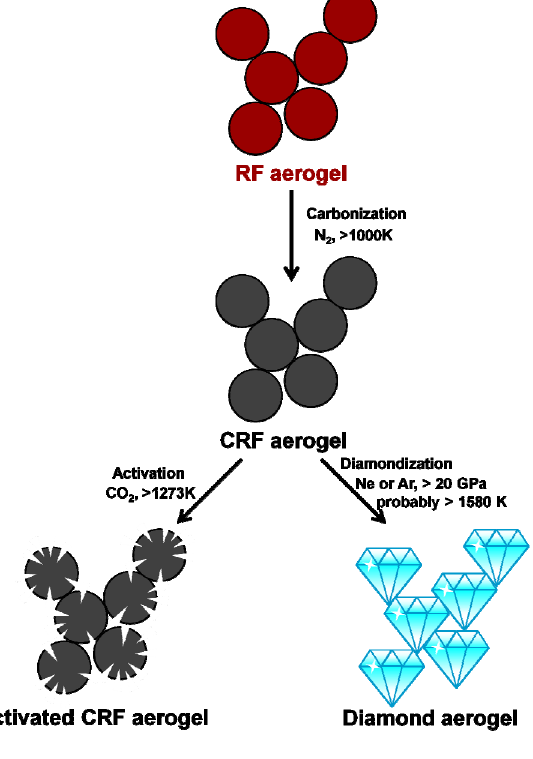
Figure 6. The scheme of the preparation of a carbonized RF (CRF) aerogel, activated CRF aerogel and diamond